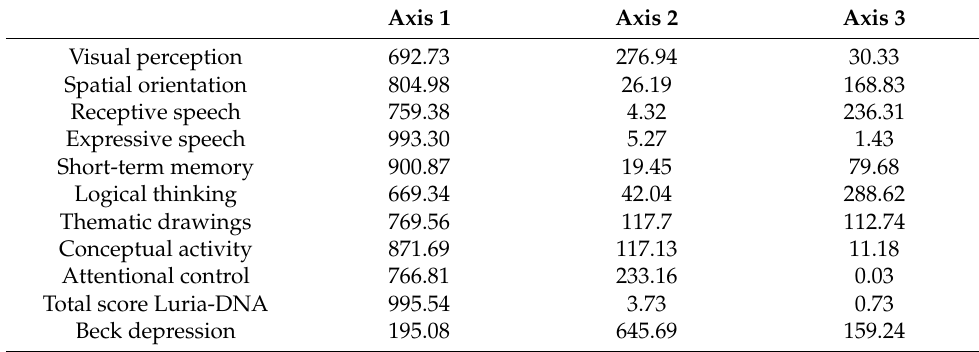
Table 3. Relative contribution of factor to element.